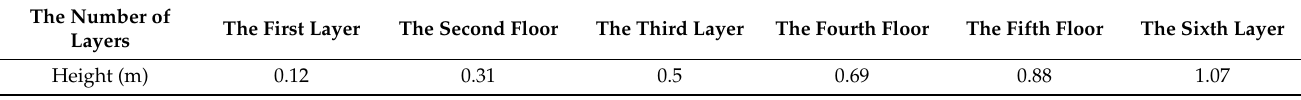
Table 1. Setting the height of each layer of the